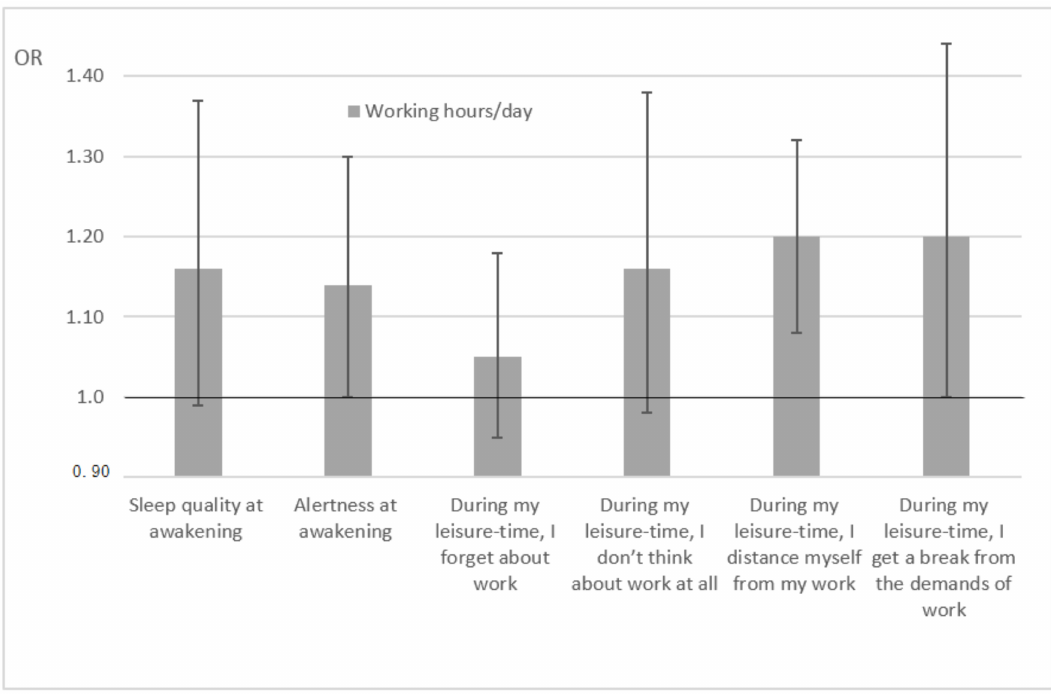
Figure 1. Odds ratios (OR) for association between working hours/day and ratings of sleep quality and alertness, and recovery and detachment (midsleep time accounted in the analysis). Error bars indicate 95%